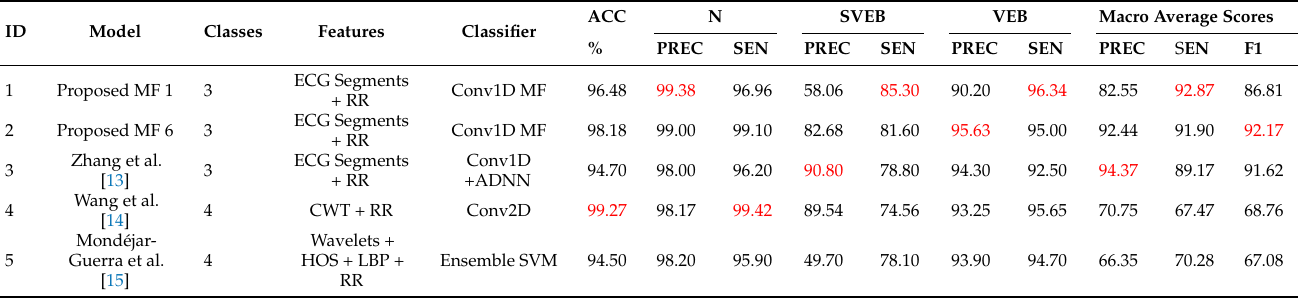
Table 5. Comparison between the Conv1D MF model and state-of-the-art inter-patient ECG classifi- cation methods. The best results per column (metric) are highlighted in